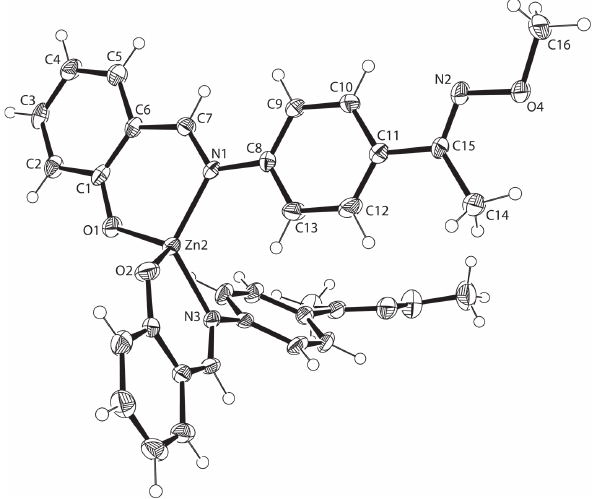
Table 1: Data collection and